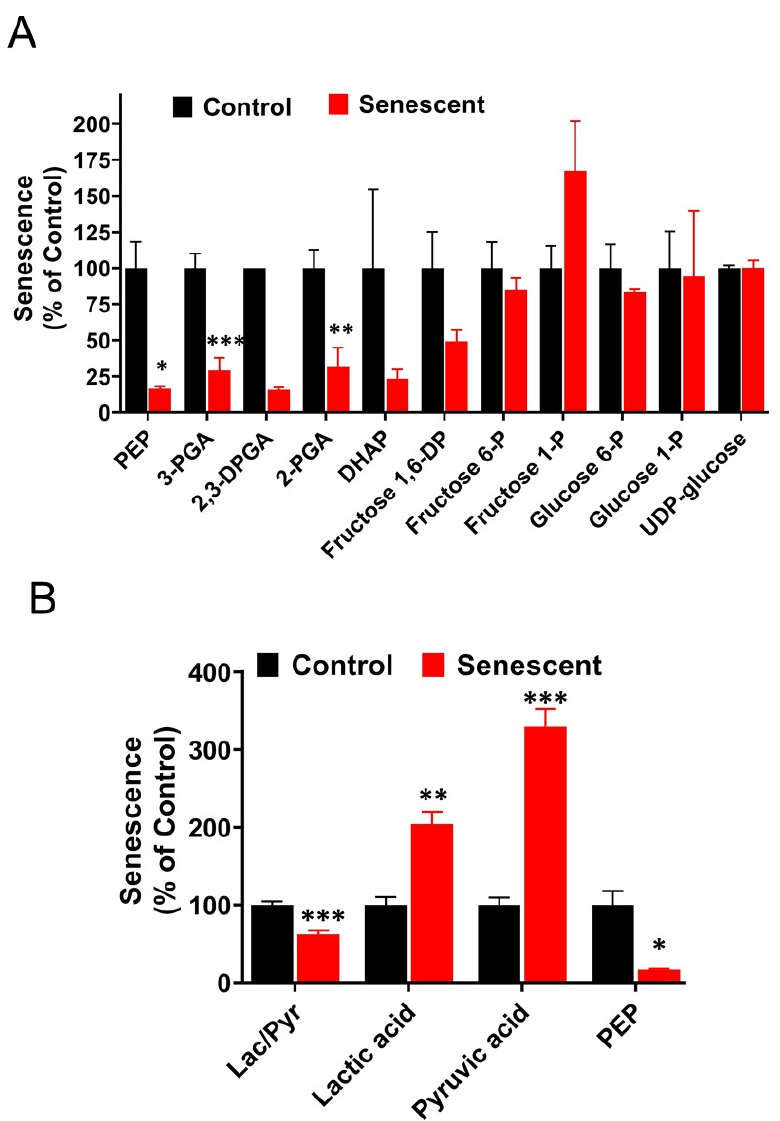
Figure 6. ( A ). Levels of glycolysis-related metabolites in control and senescent HCT-116 cells. Metabolites in senescent cells are expressed as percent of control based on protein concentration of samples. Results are ± SD of triplicate samples. ( B ). Levels of pyruvate and lactate and their ratio in control and senescent HCT-116 cells. * p value < 0.05; ** p value < 0.01, *** p value < 0.001. Actual values obtained from analysis (nmoles/g protein) including p values and significance are presented in Table S2.